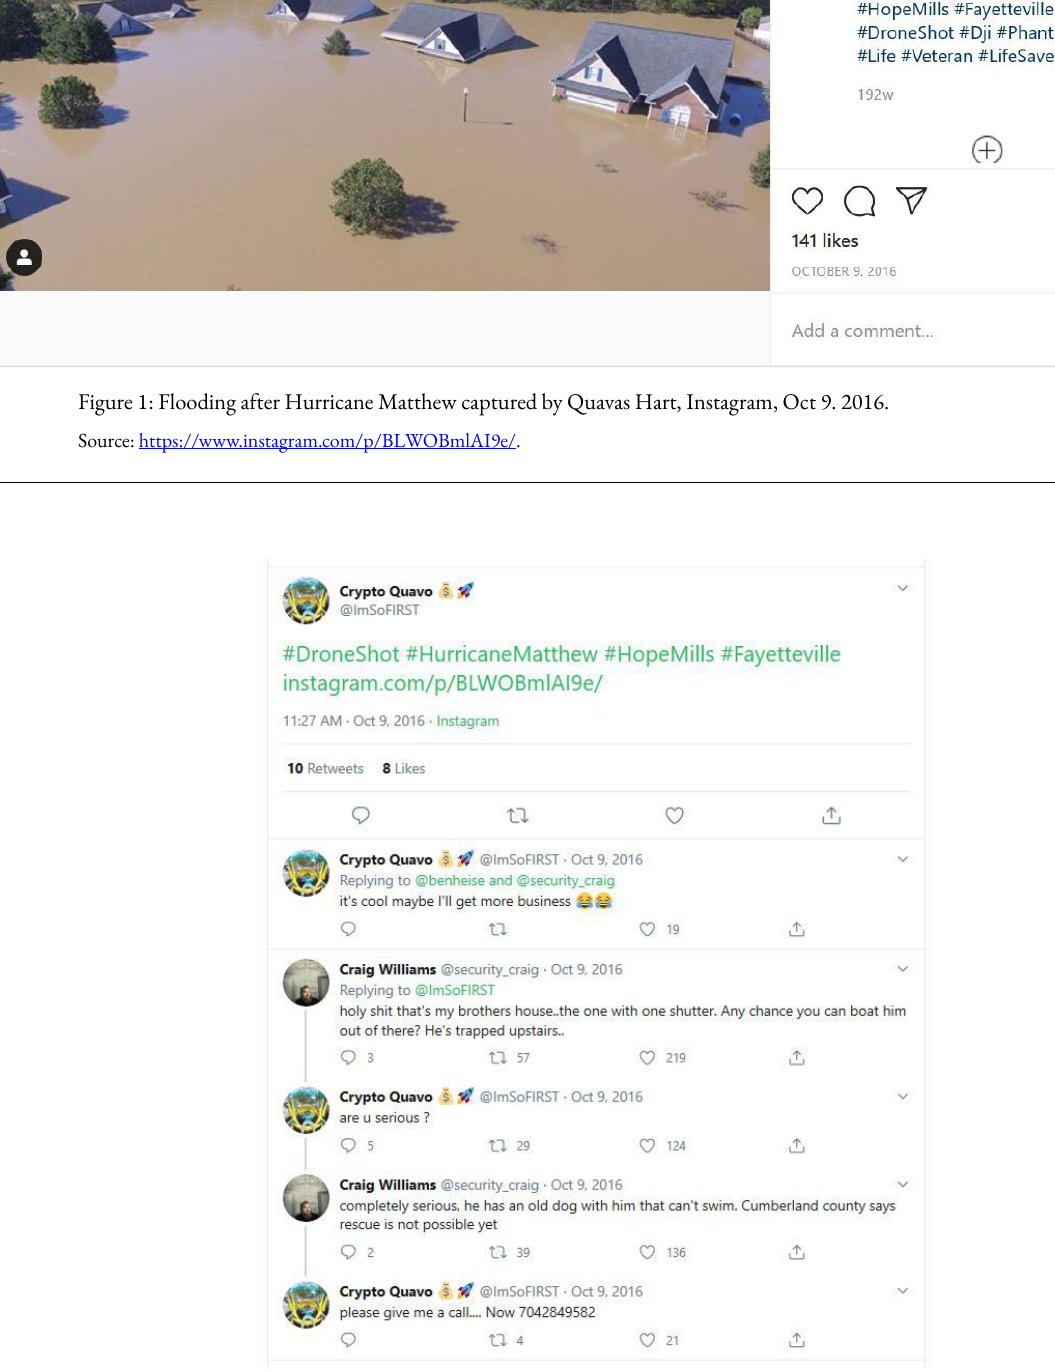
Figure 2: Twitter conversation between Quavas Hart and Craig Williams Twitter, Oct 9, 2016. Source: